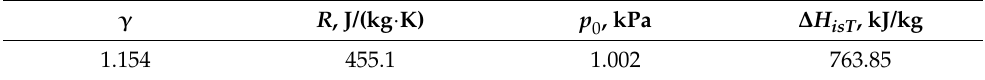
Table 2. Constants of the Tammann equation of state and the resultant isentropic enthalpy